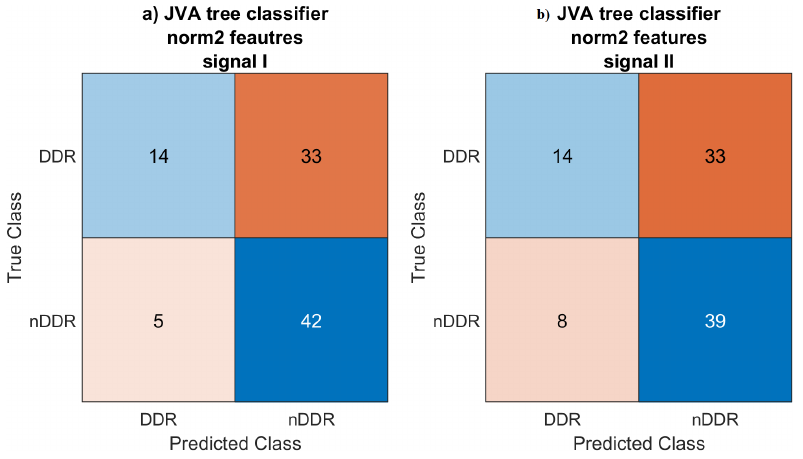
Figure A9. Confusion matrices for norm2 features used in the JVA decision tree classifier for the ( a ) first and ( b ) second